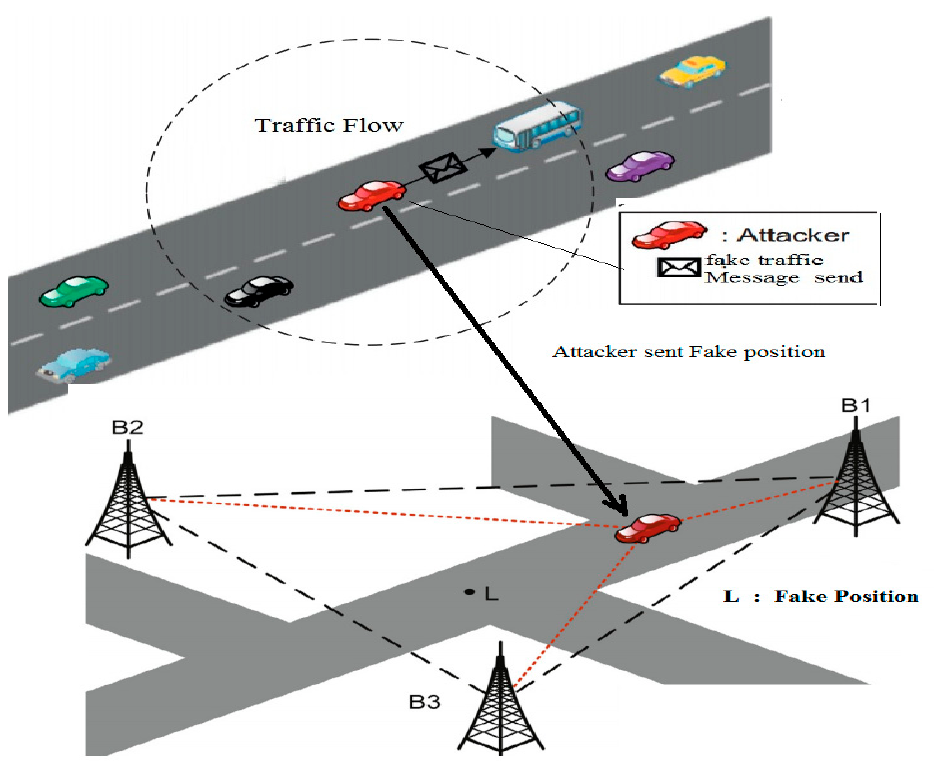
Figure 5. Preprocessing feature extraction.